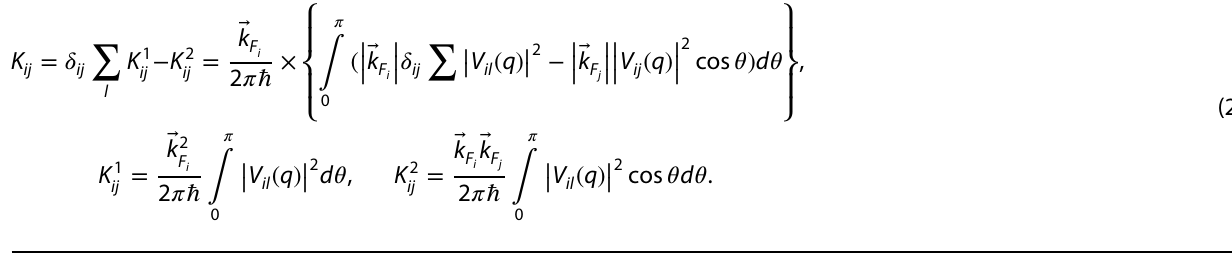
Fig. 4 View of the output data of the THz pulse detec- tor. The figure shows a the oscillograms of the electric field of the THz pulse signal in the time domain. Figure b shows the corresponding THz pulse waveform obtained by the fast Fourier transform. The spectrum was obtained for sample № CO1 at a tempera- ture of 90